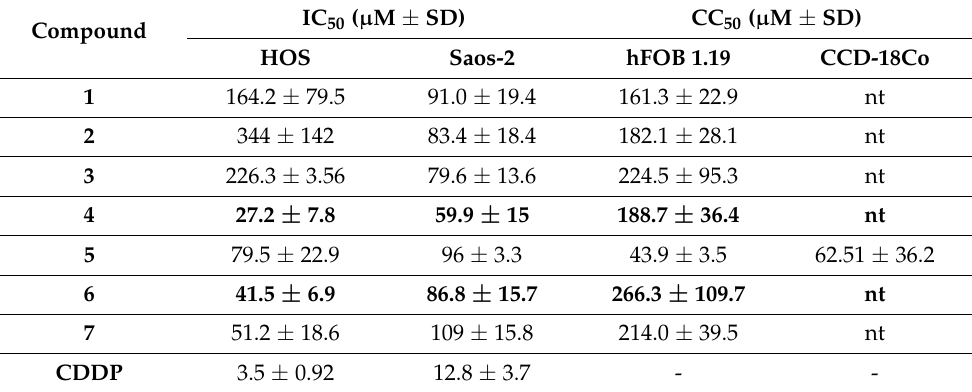
Table 4. Effect of compounds 1 – 7 and cisplatin (CDDP)on proliferation of osteosarcoma HOS and Saos-2 cells and viability of human normal osteoblasts hFOB 1.19 and human normal colon fibroblasts CCD-18Co. The cells were incubated with each compound for 96 h (proliferation assay) and 24 h (viability assay), and an MTT assay was conducted. The results were presented as IC 50 (50% inhibitory concentration—a concentration resulting in 50% inhibition of cell proliferation and CC 50 (50% cytotoxic concentration—a concentration resulting in a 50% decrease in cell viability). IC 50 ( µ M ± SD) CC 50 ( µ M ± SD) Compound HOS Saos-2 hFOB 1.19 CCD-18Co 1 164.2 ± 79.5 91.0 ± 19.4 161.3 ± 22.9 nt 344 ± 142 83.4 ± 18.4 182.1 ± 28.1 nt 226.3 ± 3.56 79.6 ± 13.6 224.5 ± 95.3 27.2 ± 7.8 59.9 ± 15 188.7 ± 36.4 41.5 ± 6.9 266.3 ± 109.7 214.0 ± 39.5 3.5 ± 0.92